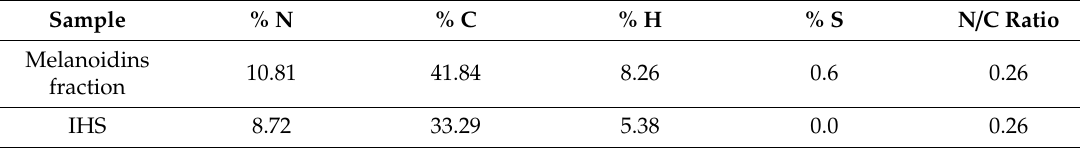
Table 2. Elemental composition of melanoidins fractions from IHS.